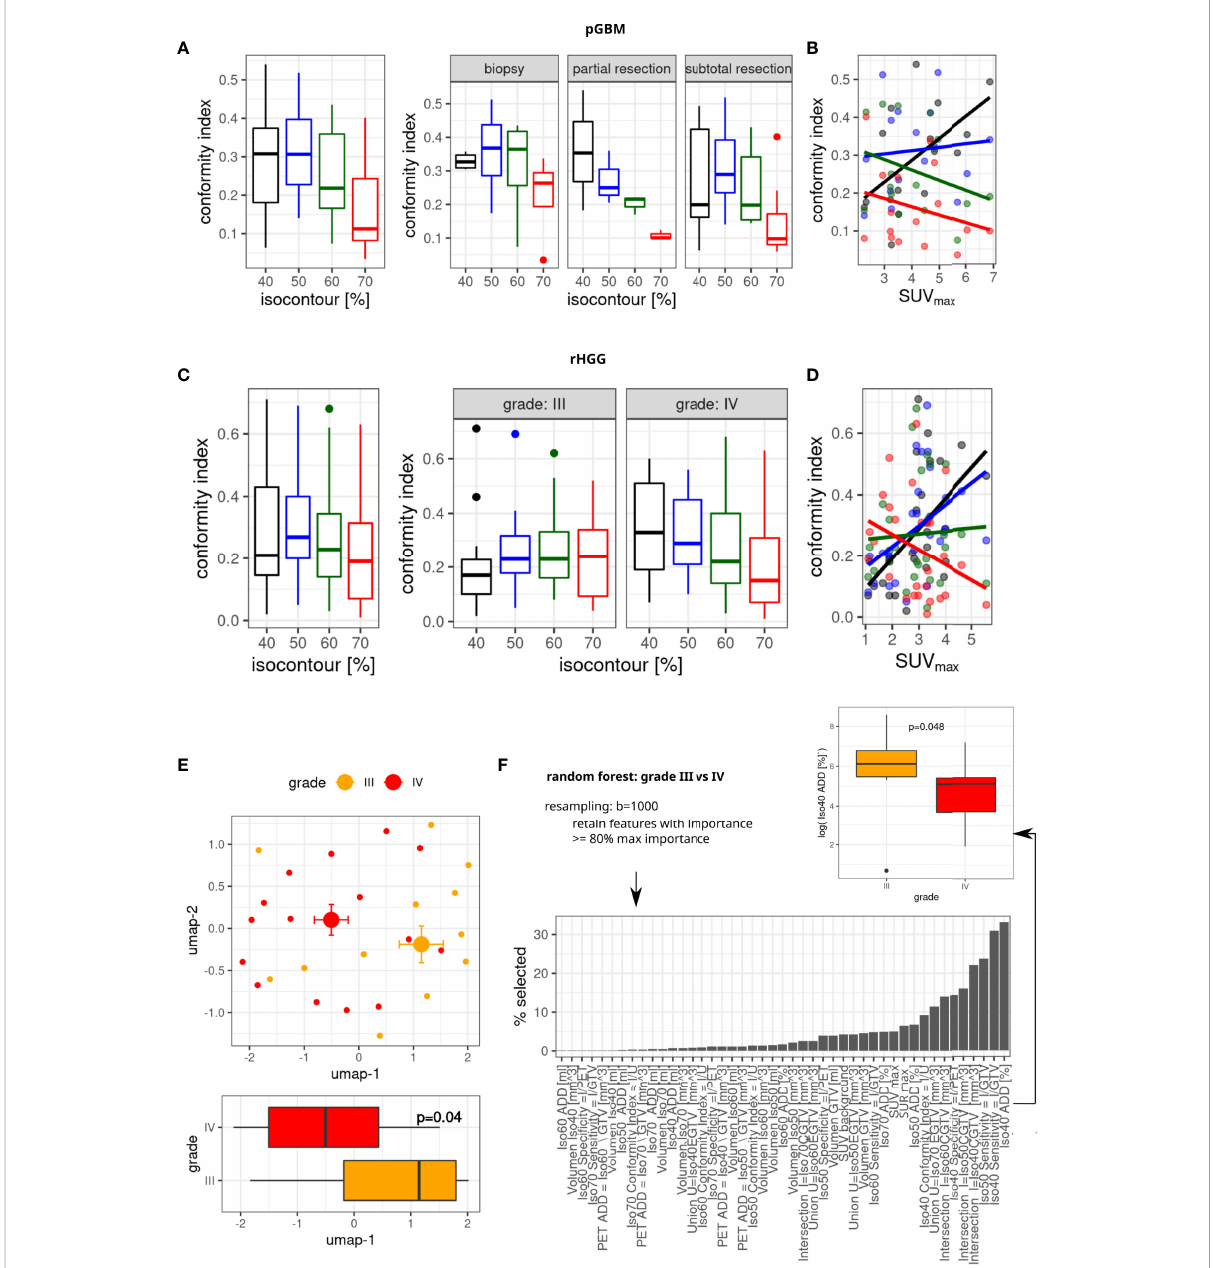
FIGURE 5 Concordance between GTV and 18 F-FET-PET isocontours. Conformity index (CI) for different isocontours (A, C) , split by degree of resection (pGBM, A, right) and radiographic reRT tumor grade (C, right). (B, D) Association between SUVmax and conformity index (linear model fi ts). (E) Umap representation of all n = 45 volumetric features, median, and SE (top part). Bottom part: differences in umap-1 values between tumor grades (linear model Wald type p- value). (F) Identi fi cation offeatures separating grade using random forests analysis (top part); distribution offeature frequencies in bottom part, and differences in top-ranked feature is shown on the right (linear model p-value). n = 27 patients. GTV, gross tumor volume; pGBM, primary